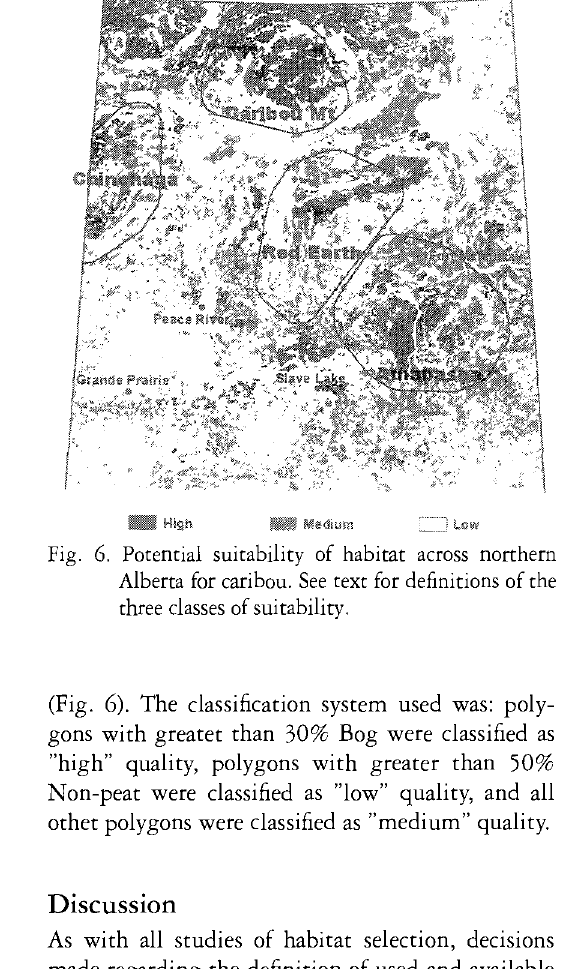
Fig. 6. Potential suitability of habitat across northern Alberta for caribou. See text for definitions of the three classes of